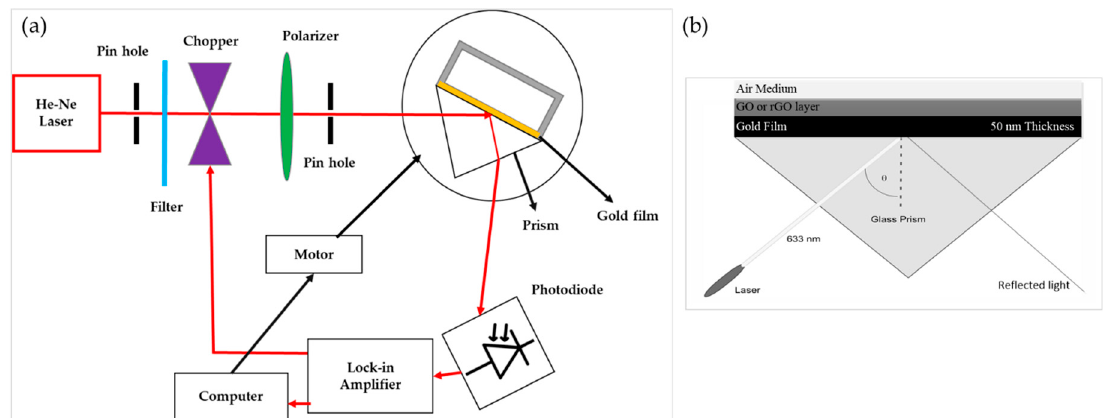
Figure 7. ( a ) The schematic diagram of the customized Kretschmann configuration-based system for SPR measurements, ( b ) the SPR-based sensing system.